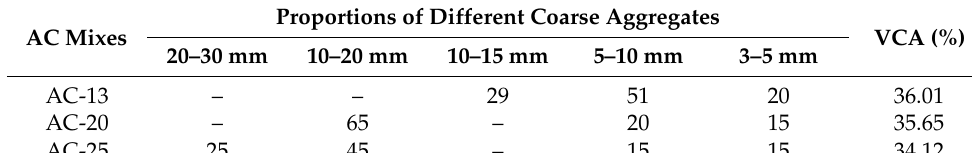
Table 5. Results of the vibrating compaction test of coarse aggregates.